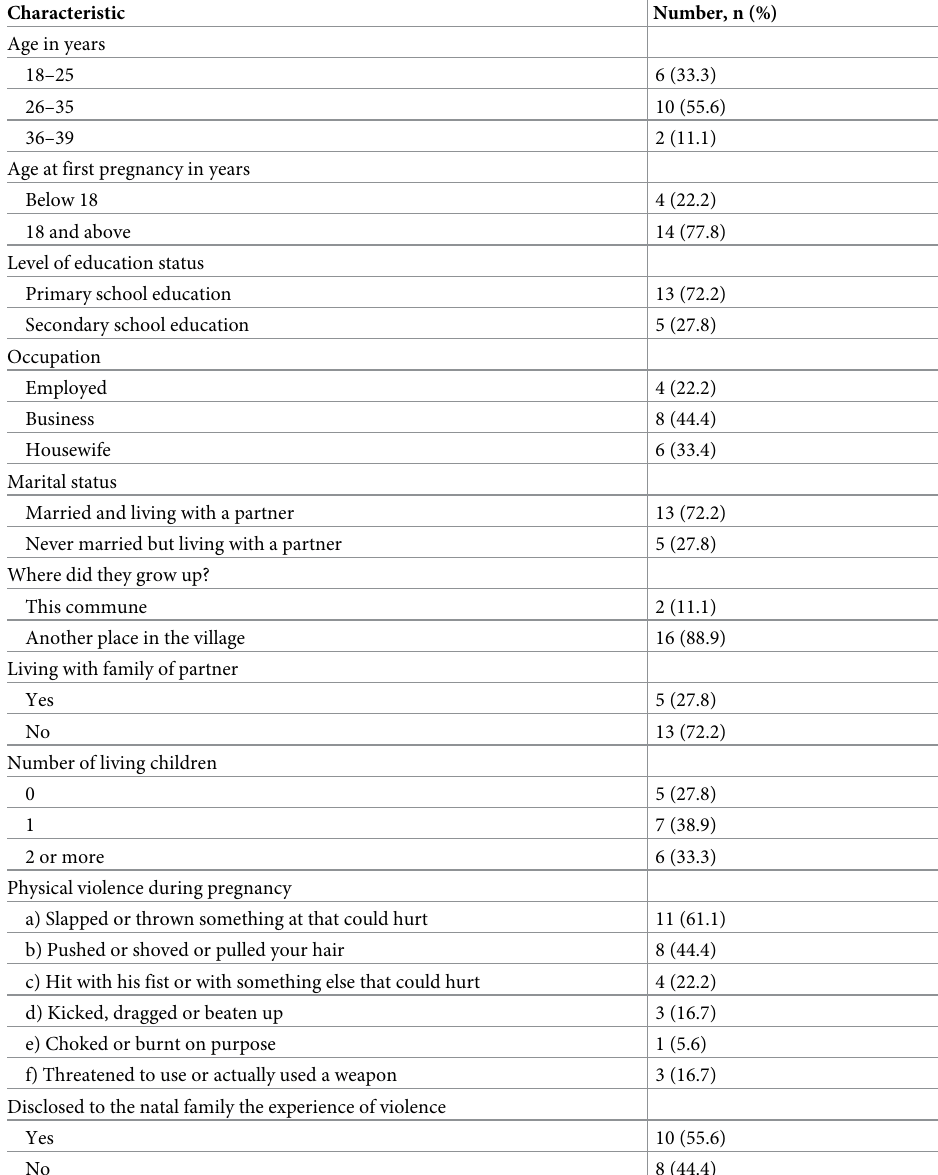
Table 1. Characteristics of participants (n =